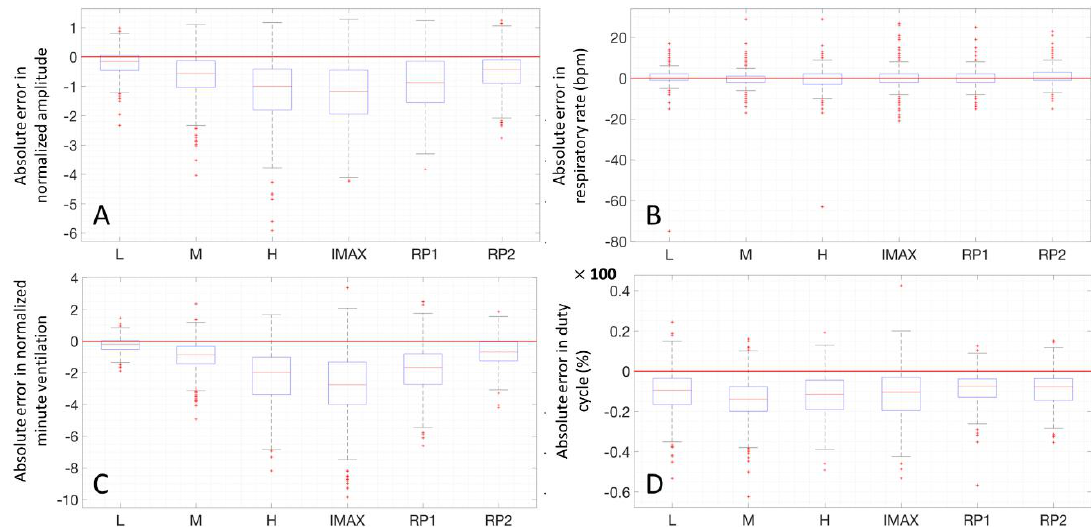
Figure 10. Absolute error box plots, all subjects, different positions at rest, all parameters: normalized amplitude ( A ), respiratory rate ( B ), normalized minute ventilation ( C ) and duty cycle ( D ). The positions shown are the following: standing (I), seated (II), supine (III), right side (IV), left side (V).